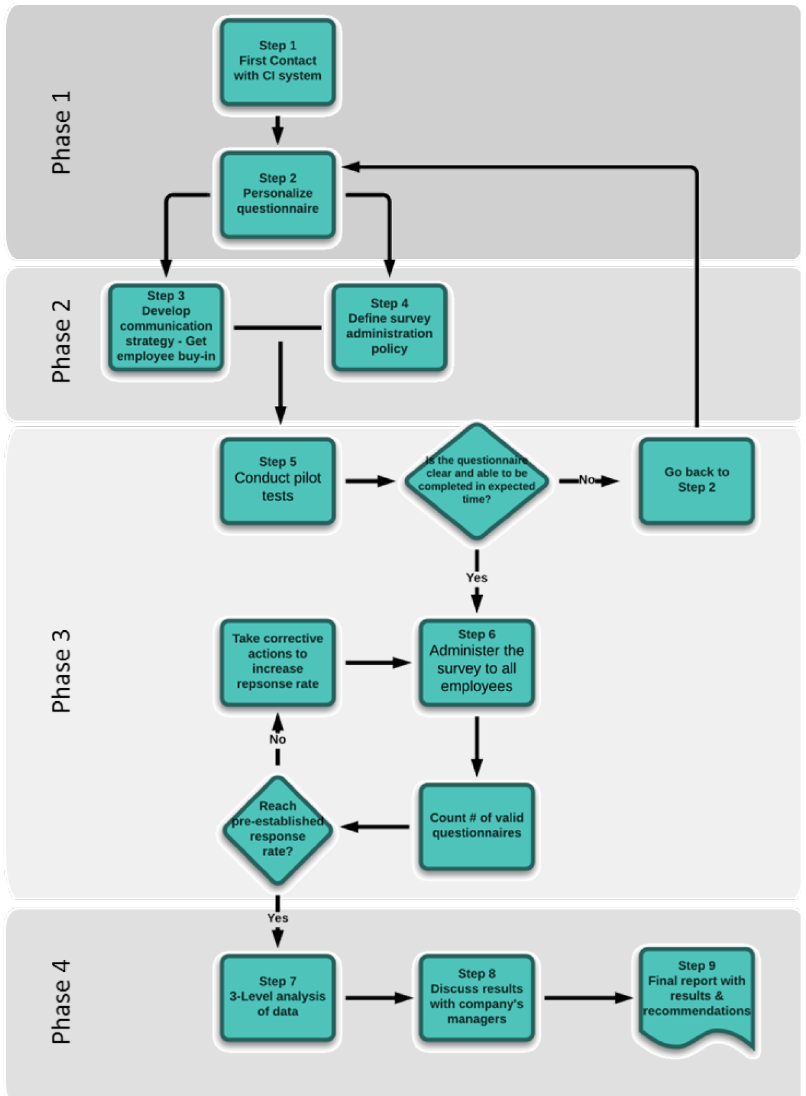
Figure 2. CIAM 9-step diagnostic